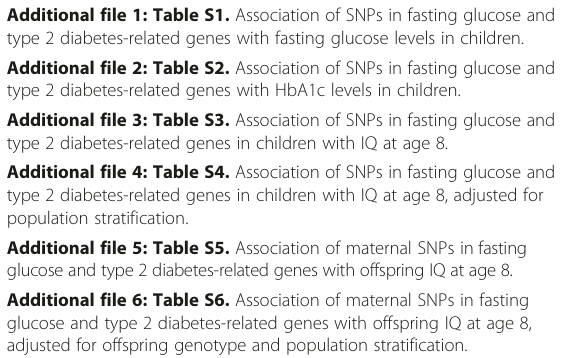
Additional file 6: Table S6. Association of maternal SNPs in fasting glucose and type 2 diabetes-related genes with offspring IQ at age 8, adjusted for offspring genotype and population